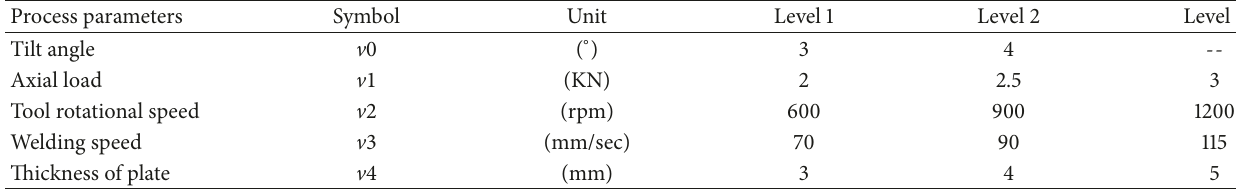
Table 2: Important input factors and their levels.